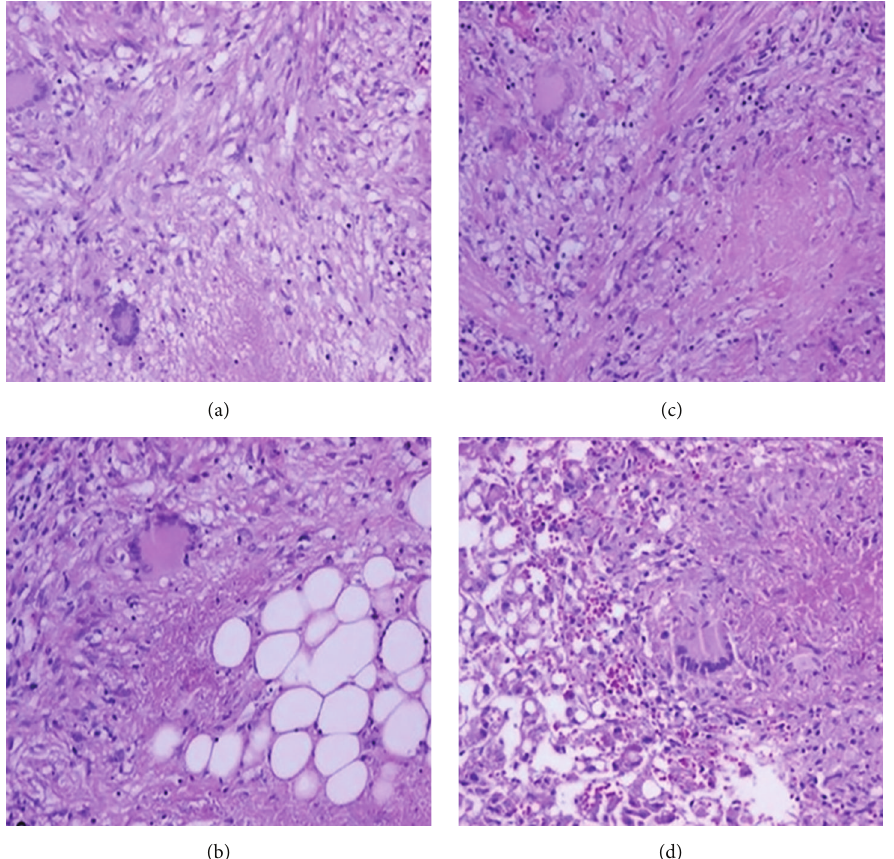
Figure 2: Chronic caseating granulomas with central necrosis: (a) fimbria; granuloma; and Langhans’ giant cells (H&E, × 200), (b) peri- toneum; granulomatous peritonitis; and Langhans’ giant cell (H&E, × 200), (c) omentum; area of caseation between epithelioid histiocytes; lymphocytes; and Langhans’ giant cell (H&E, × 200), (d) liver; steatosis; and Langhans’ giant cell with area of caseation (H&E, ×